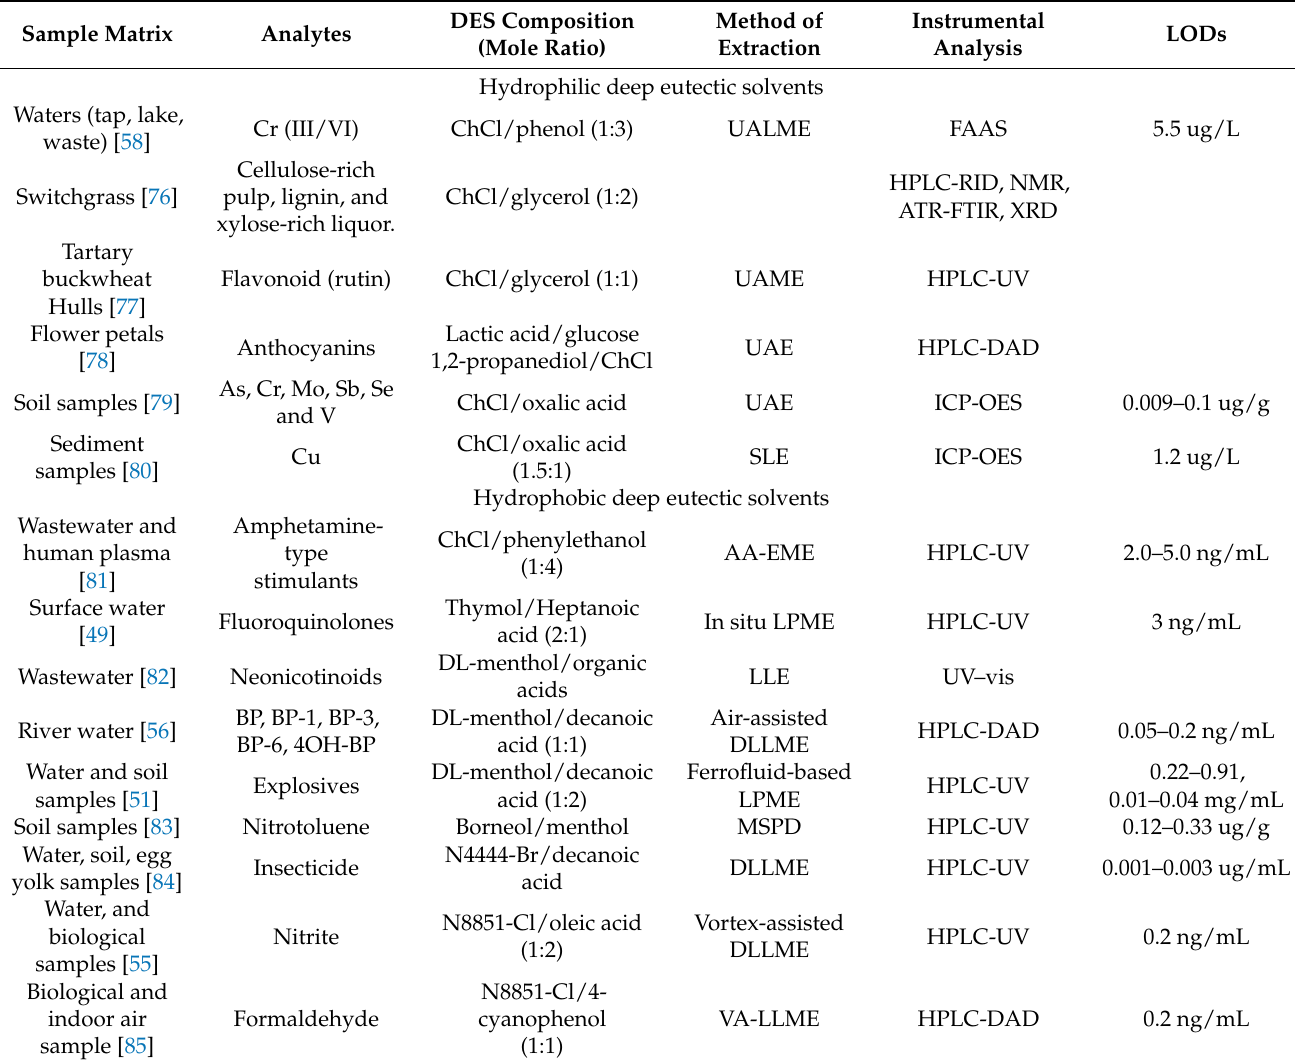
Table 2. Compilation of application of DESs in extraction from various types of environmental